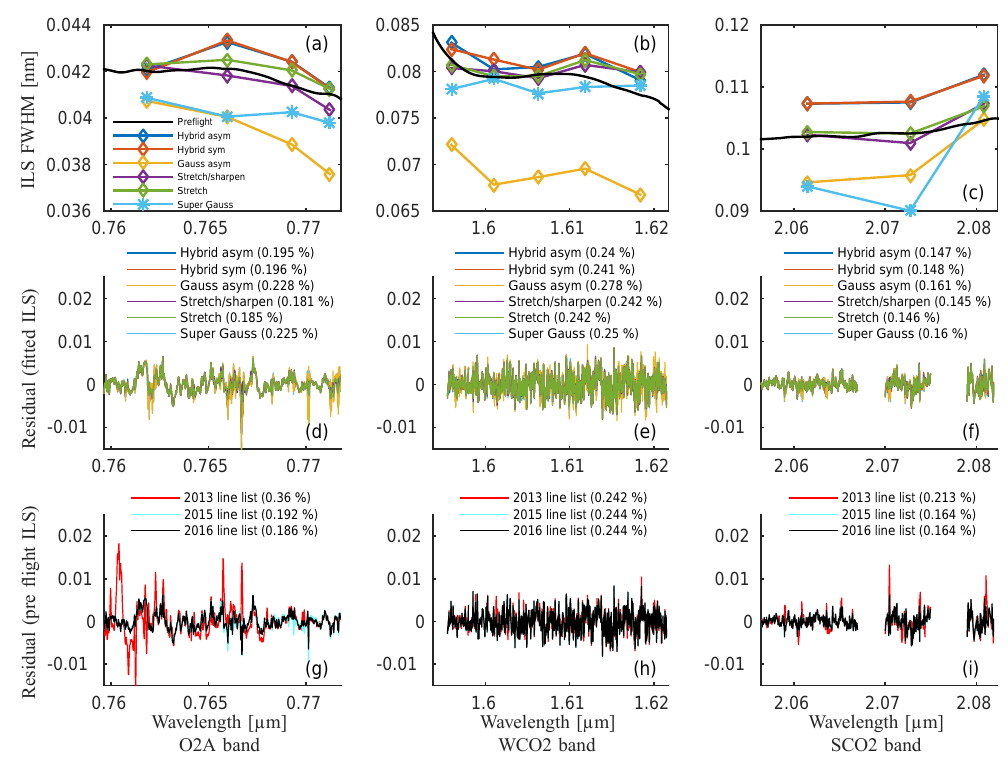
Figure 5. (a–c) FWHM of ILS derived using six different ILS functions at each fitting window for three OCO-2 bands. The black line denotes preflight ILS FWHM at each spectral pixel. (d–f) Fitting residuals at each window using different ILS function forms and the rms of concatenated residuals from all fitting windows. (g–i) Residuals from fitting only the preflight ILS convolved with different versions of solar line lists and polynomial scale factors. This analysis is for footprint 6 on 29 March